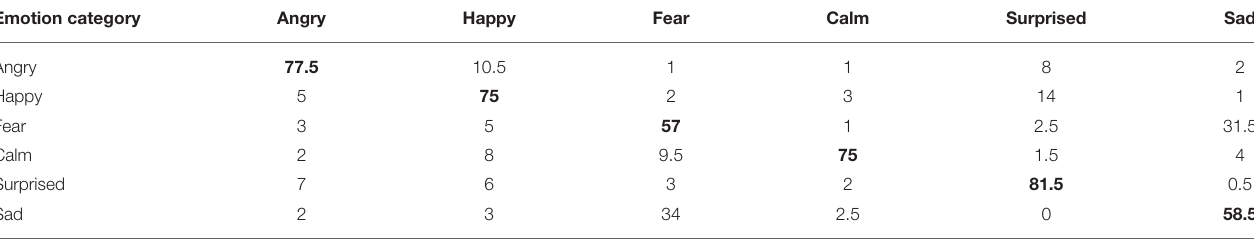
The bold values represent the recognition rate of the adopted method. TABLE 8 | Recognition rate of this method in CASIA. Emotion